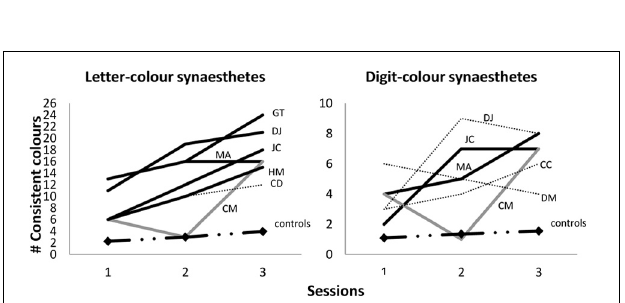
FIGURE 2 | Percentage of consistent colors selected by the three participant groups (see legend) in their immediate consistency of 36 graphemes within Sessions 1, 2 and 3 (ages 6/7, 7/8, 10/11 respectively). Intervening years have no data because no testing took place at these ages.